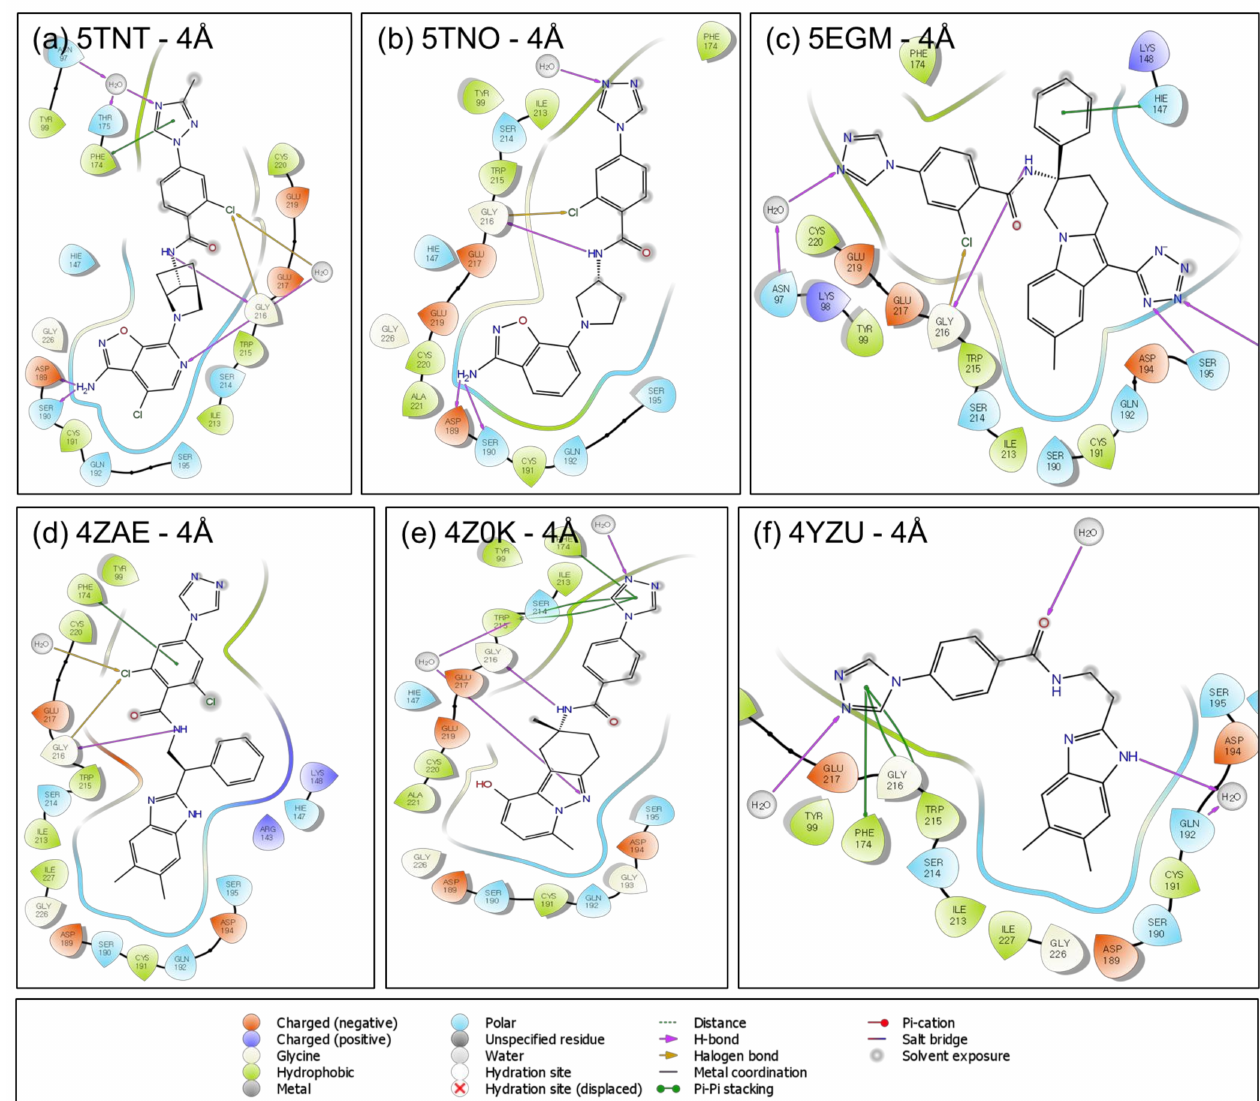
Figure 3. Protein–ligand interaction diagrams (LID) are shown here for all the FIXa co-crystal ligands within 4 Å distance: ( a ) for 5TNT, ( b ) for 5TNO, ( c ) for 5EGM, ( d ) for 4ZAE, ( e ) for 4Z0K and ( f ) for